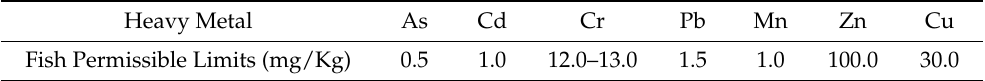
Table 1. Permitted limits of heavy metal concentration in fish (mg/kg) [63].